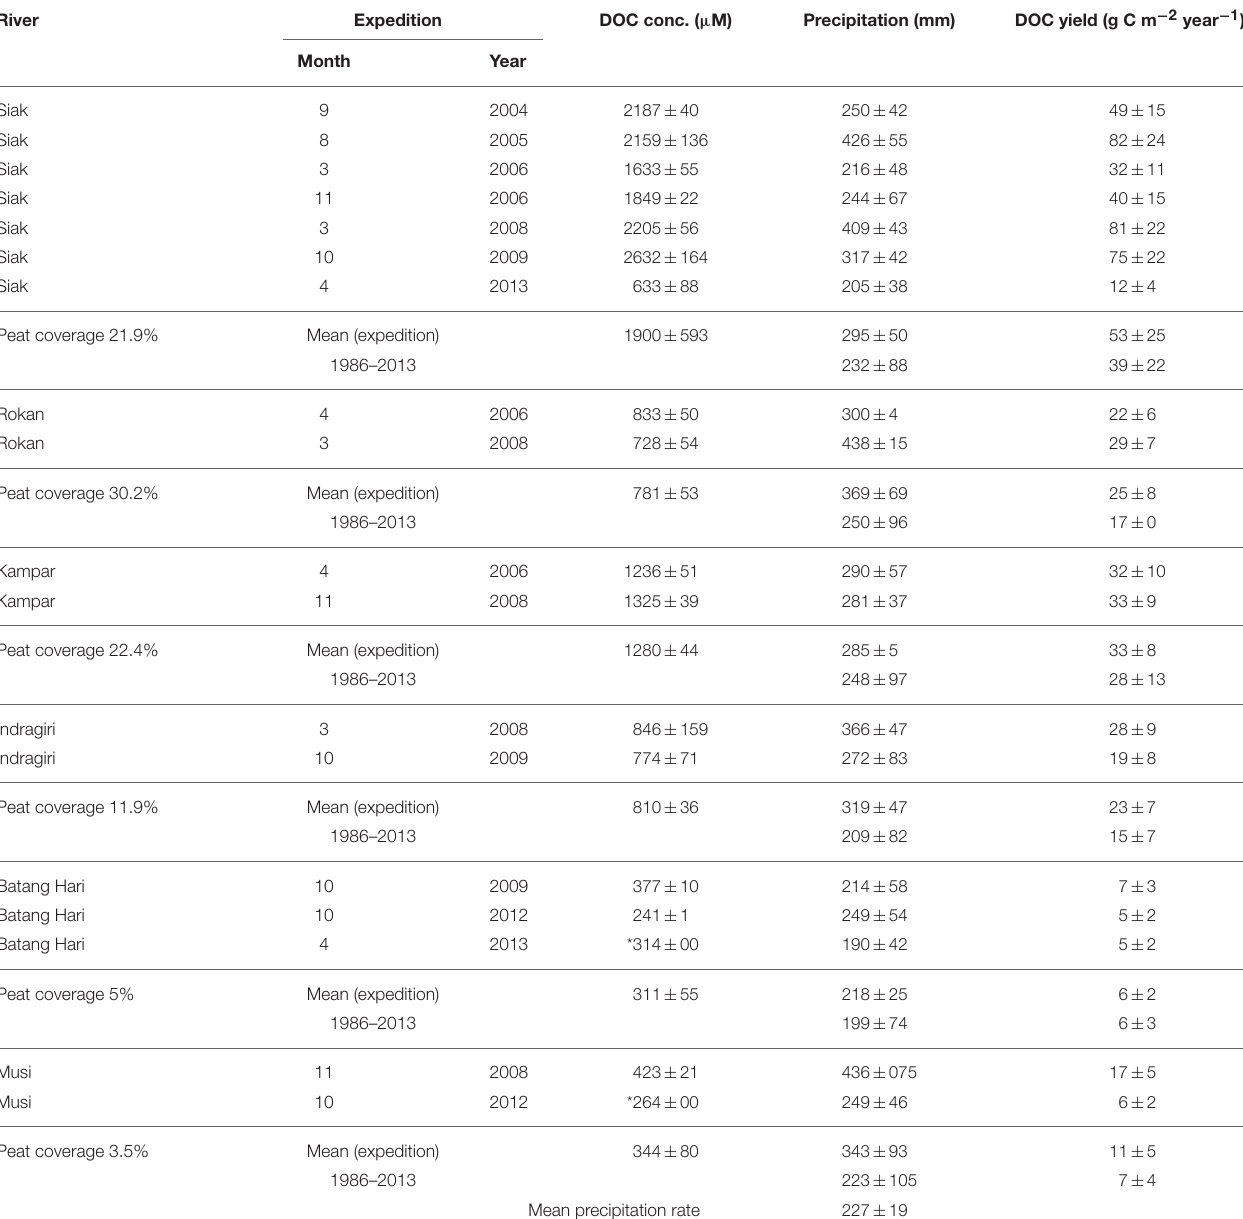
TABLE 1 | Rivers and expeditions as well as riverine DOC end-member concentrations, monthly precipitation rates (Schneider et al., 2014) averaged for the catchment area of the respective rivers (Table S2), and the DOC yields calculated according to Equation